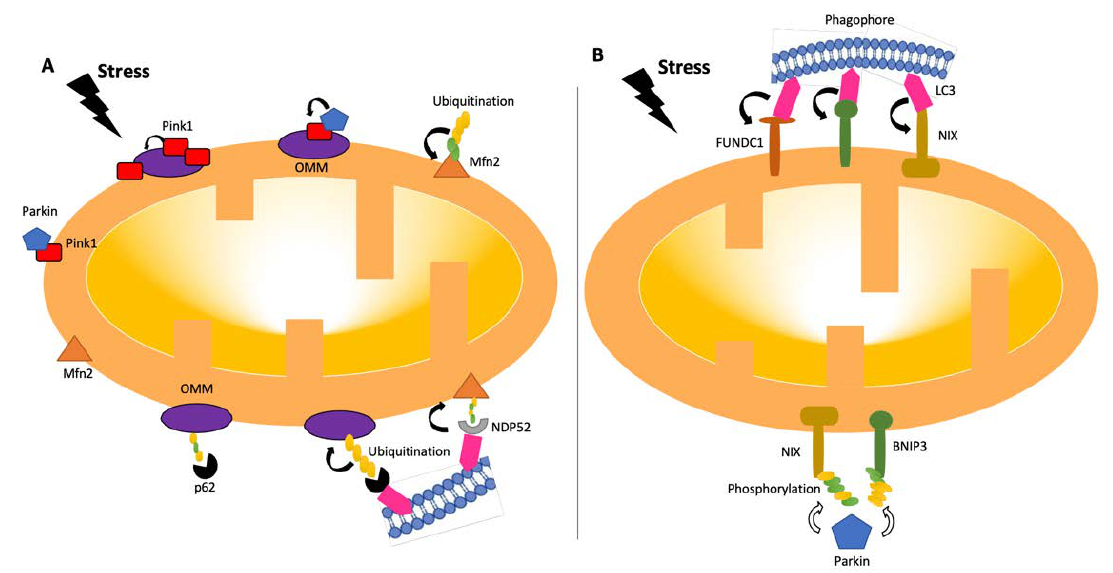
Figure 2. Pathways of mitophagy. Mitophagy pathways are either receptor- ( B ) or ubiquitin- ( A ) dependent [24,26]. Under stress conditions, mitochondria become dysfunctional, and PINK1 accu- mulates and stabilizes on the outer membrane of mitochondria, triggering PARKIN activation [27]. PARKIN recruits the ubiquitination and phosphorylation processes of outer-membrane proteins. Adaptor proteins, such as p62 and NDP52, recognize phosphorylated poly-ubiquitin chains. LC3 connects to adaptor proteins, and phagophores recognize LC3. In the receptor-mediated pathway ( B ), LC3 attaches to FUNDC1, BNIP3, or NIX receptors. BNIP3 or NIX can also be phosphorylated (PARKIN-mediated or -independent). LC3: microtubule-associated protein 1A/1B-light chain 3; BNIP3: Bcl-2/adenovirus E1B 19-kDa-interacting protein 3; FUNDC1: mitochondrial receptor FUN14 domain-containing 1; NIX: BCL2/adenovirus E1B 19 kDa protein-interacting protein 3-like.